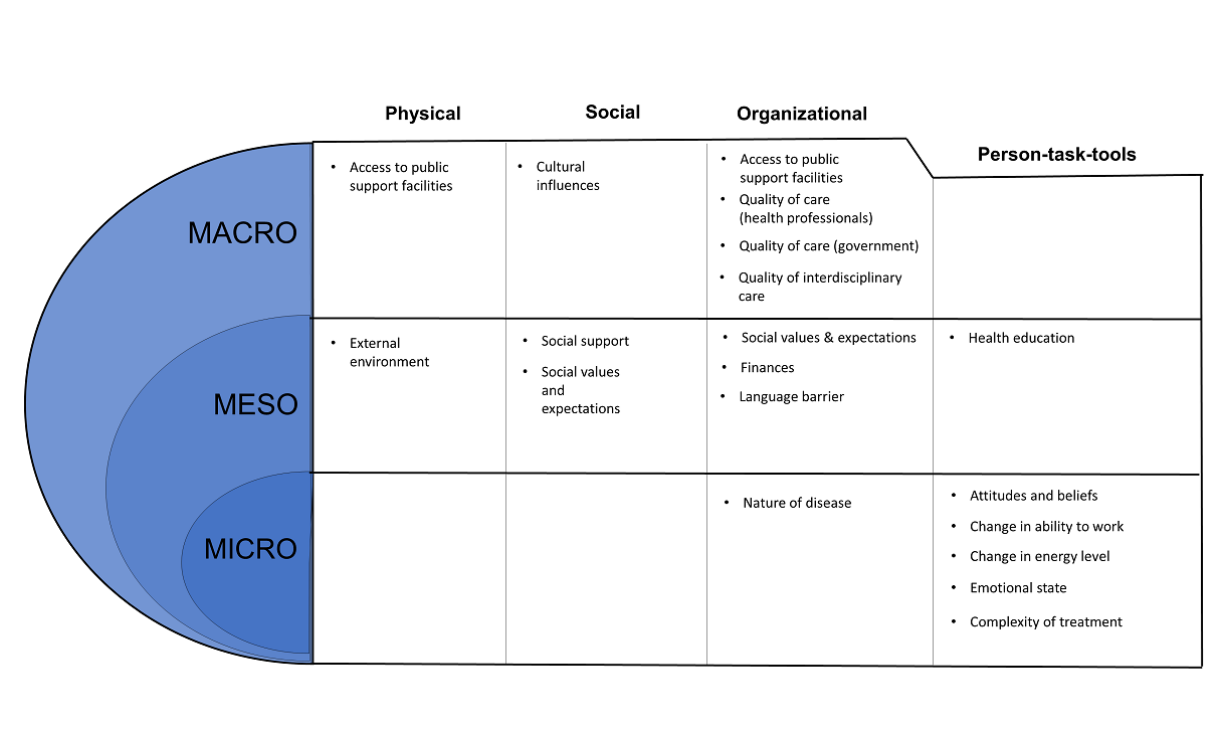
Figure 3. Contextual factors that influence patient work, separated on the basis of their allocation in the patient work system and whether they act on a macro, meso, or micro